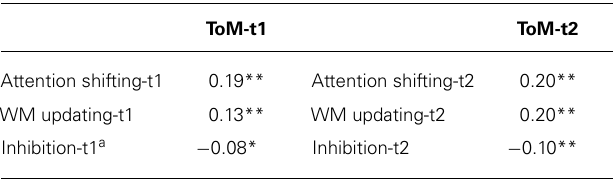
Table 2 | Concurrent correlations between EF subcomponents andToM at t1 and t2, respectively, controlled for age, gender, and fluid